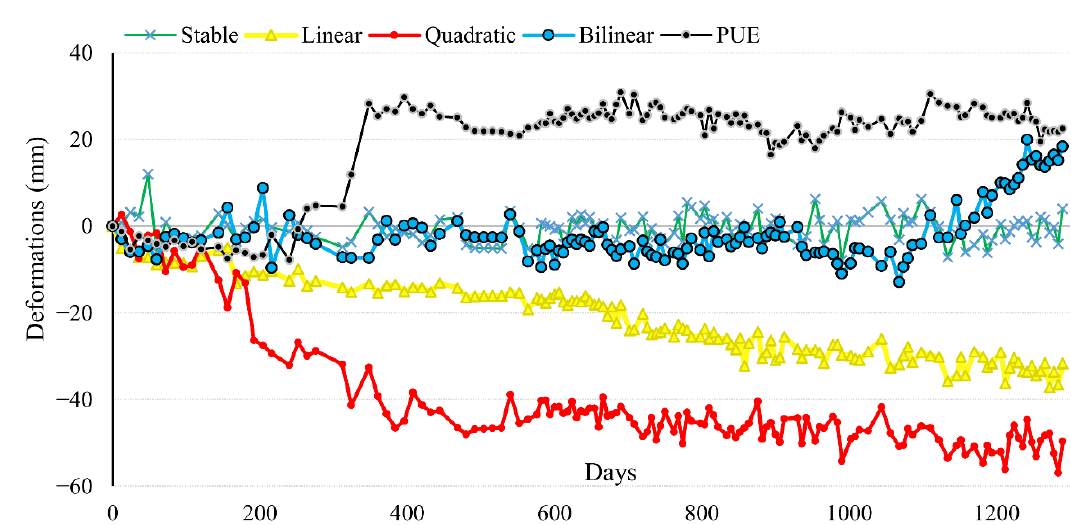
Figure 2. A graphical example of the five TS classes.